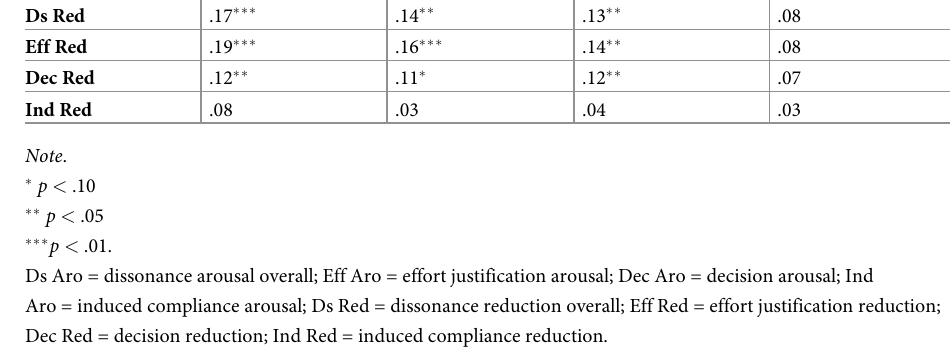
also tended to score higher on dissonance arousal than men did. In contrast, dissonance reduc- tion was negatively correlated with BIS and positively correlated with some BAS as well as SWLS and age. Women and men did not differ significantly on dissonance reduction.